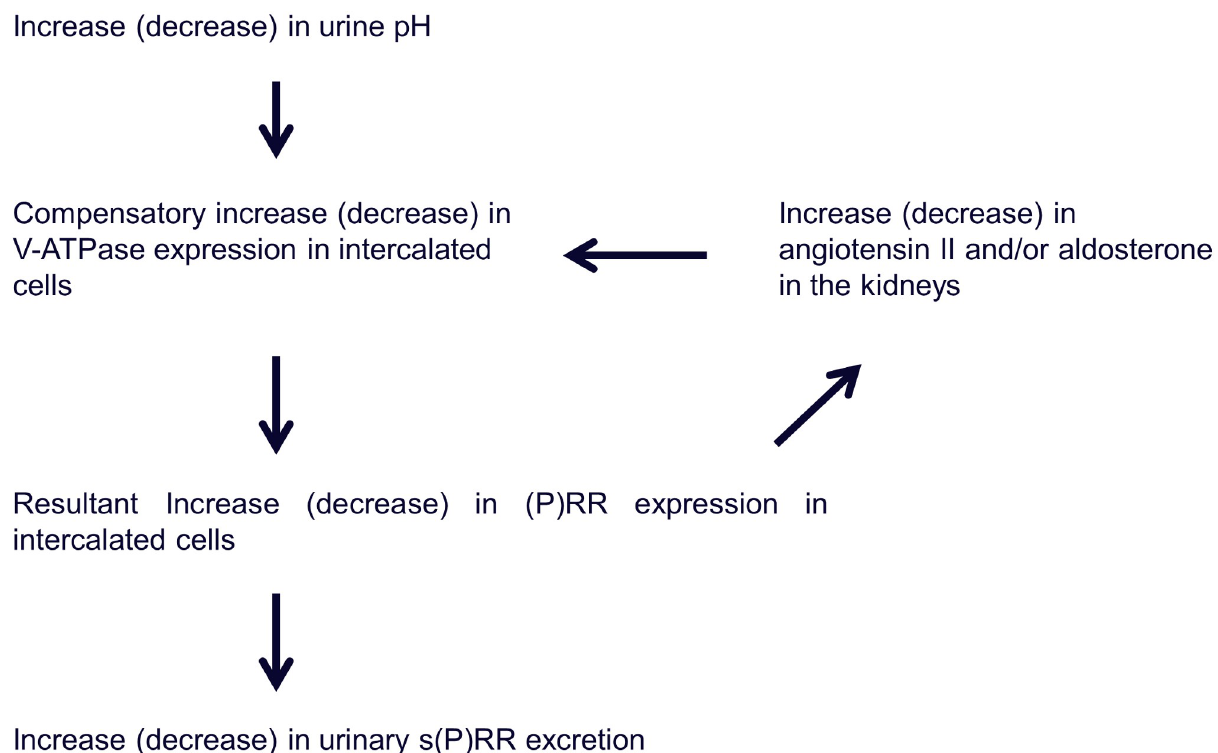
Fig 8. Hypothetical mechanism for the regulation of pH by (P)RR in kidney cells. V-ATPase, vacuolar H + -ATPase; (P)RR, (pro)renin receptor; s(P) RR, soluble (pro)renin receptor.